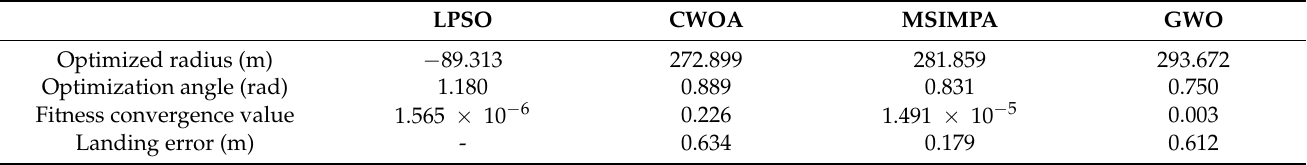
Figure 3. The best fitness iteration curve. Table 1. Optimization